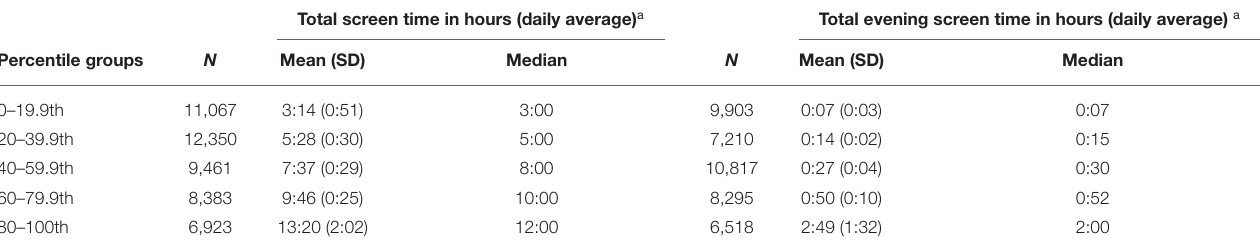
TABLE 2 | Mean, standard deviation, and median across percentile grouping for total screen time and total evening screen time. Total screen time in hours (daily average) a Total evening screen time in hours (daily average)